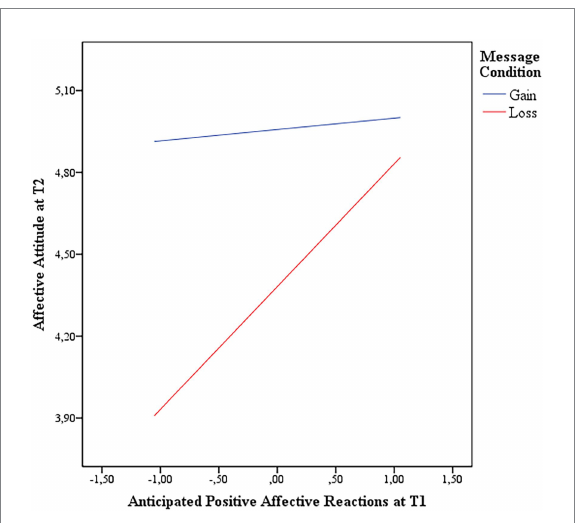
FIGURE 2 Affective attitude at time 2 in gain and loss message conditions at different levels of positive anticipated affective